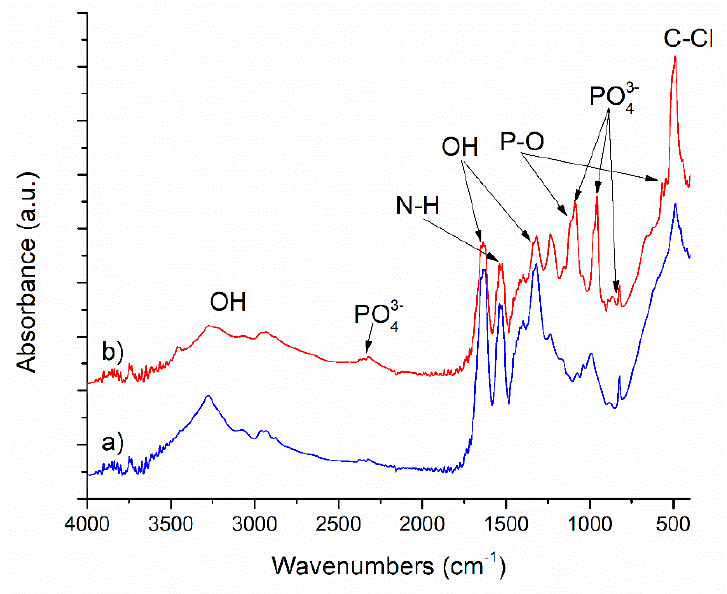
Figure 2. FT-IR spectra for the ESM: ( a ) before and ( b ) after the microwave thermal